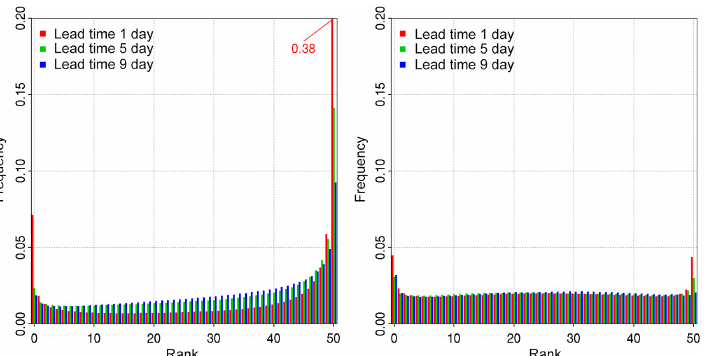
Figure 2. Left panel: Talagrand diagram of statistically downscaled EPS forecasts, lead time 1 day (red), 5 days (green) and 9 days (blue) from January 2006 to January 2010. Right panel: Talagrand diagram of statistically downscaled and post-processed EPS forecasts, lead times 1, 5 and 9, from January 2006 to January